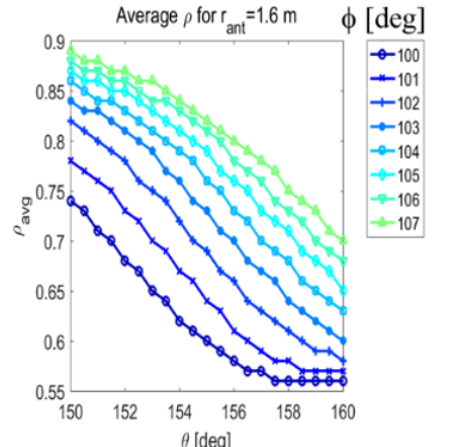
Fig. 5. The average radial position of the driven current